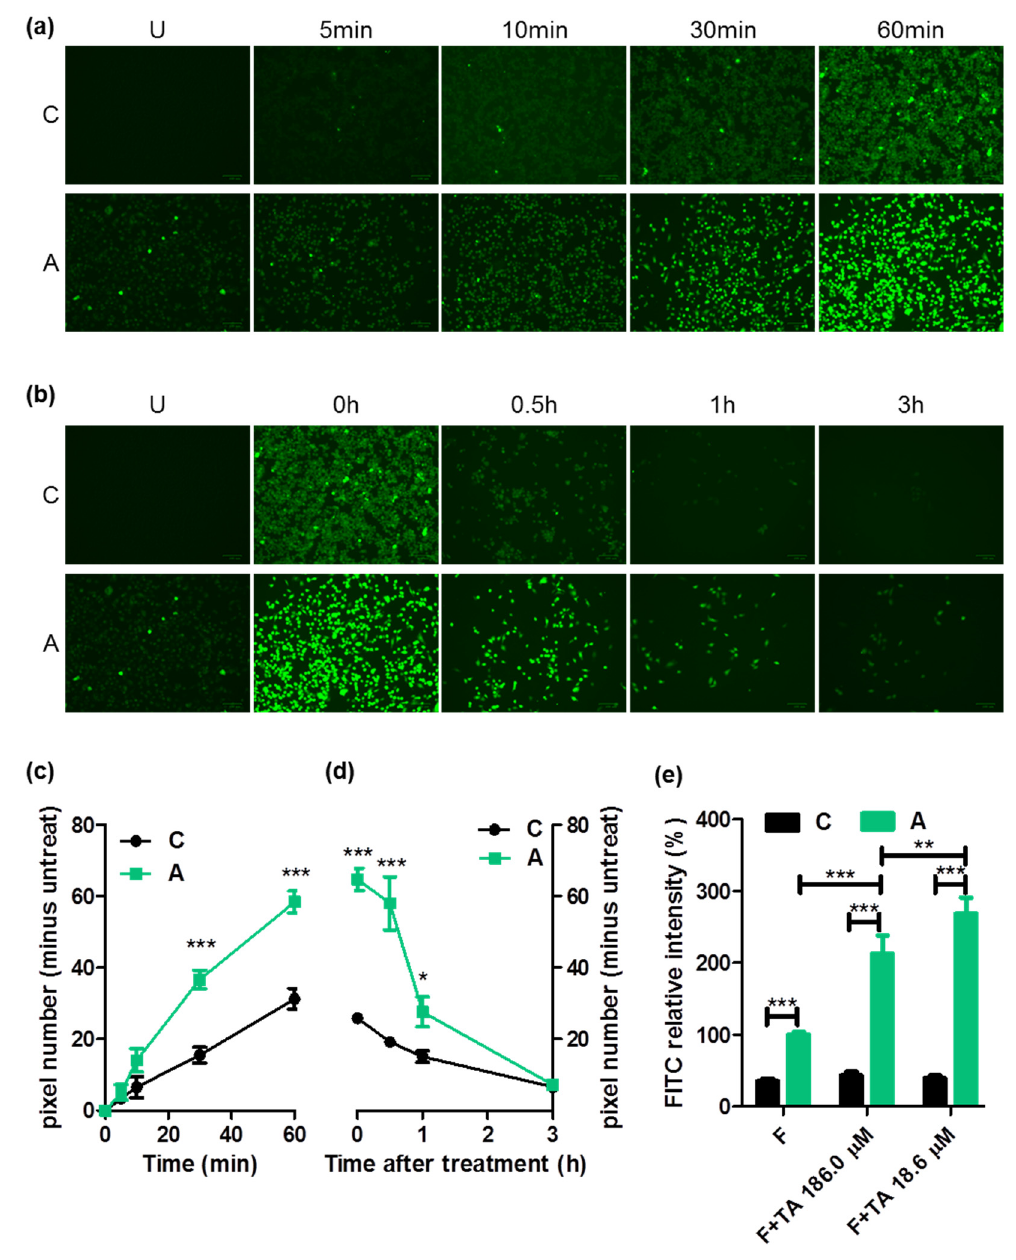
Figure 5. Fluorescein 5(6)-isothiocyanate (FITC) intake via ASBT. ( a ) FITC intensity visualized on treatment with FITC for 5, 10, 30, and 60 min. ( b ) Decline of FITC visualized at 0, 0.5, 1, and 3 h following FITC treatment. ( c ) The quantification from panel (a). ( d ) Quantification from panel ( b ). All quantification data were minus the background (untreated). ( e ) The completion of taurocholate (TA) and FITC using flow cytometry. C: control cells. A: cells expressing ASBT. U: untreated. Error bars denote the SEM, where * p < 0.05, ** p < 0.01, and *** p < 0.001.